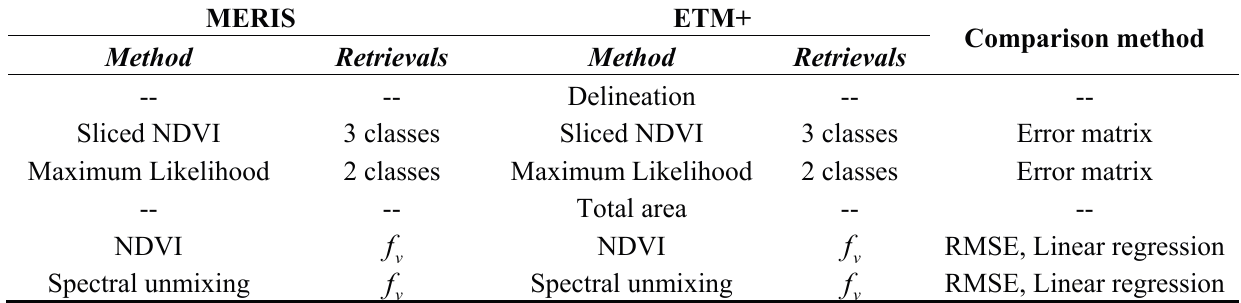
Table 2. Design of the evaluation experiment: classification of MERIS and ETM+ data provides delineation of the area covered by aquatic vegetation; area integral of fractional abundance ( f ) provides estimates of the total area covered by aquatic vegetation. The right v column shows the comparison method applied in each case. MERIS ETM+ Comparison method Method Retrievals Method Retrievals -- Delineation